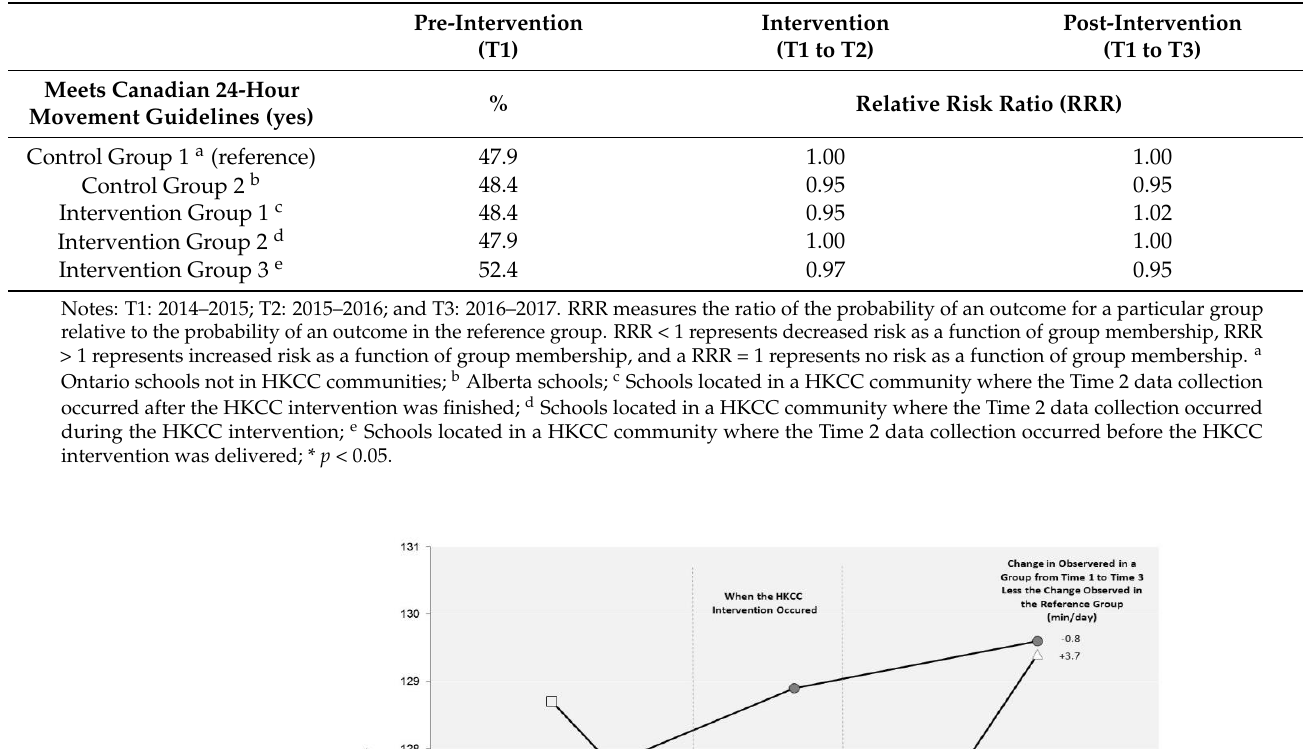
Table 3. Evaluating the impact of the Healthy Kids Community Challenge (HKCC) on moderate-to-vigorous physical activity (MVPA), strength training, and meeting the Canadian 24-Hour movement Guidelines from Time 1 (2014–2015) to Time 3 (2016–2017) in the longitudinal sample of students in the COMPASS study.